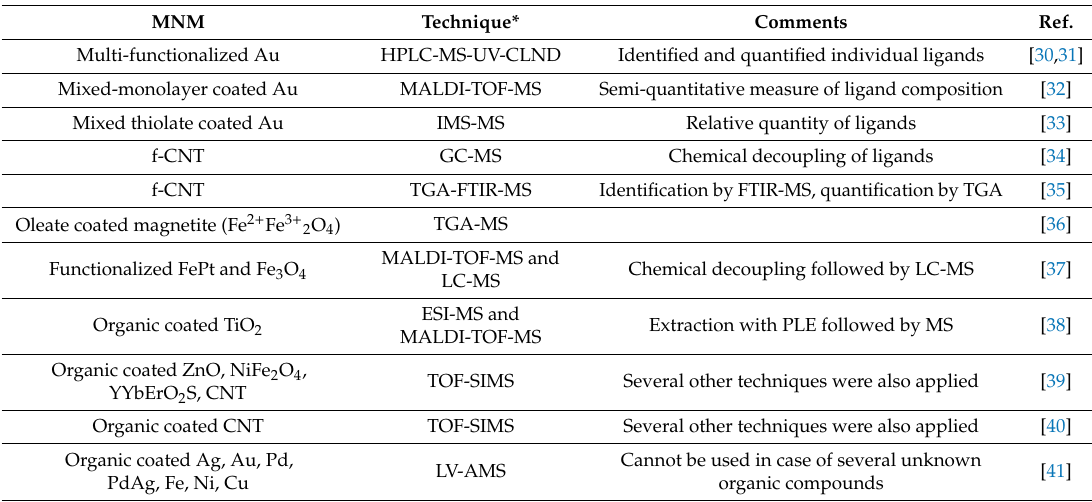
Table 1. Studies using mass spectrometry analysis of surface coating / functionalization of